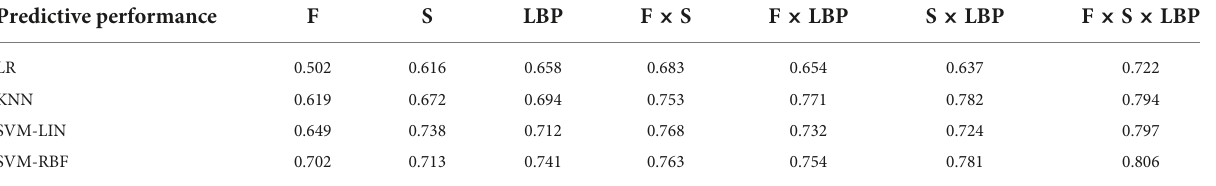
TABLE 1 Performance of face attractiveness prediction with different features.